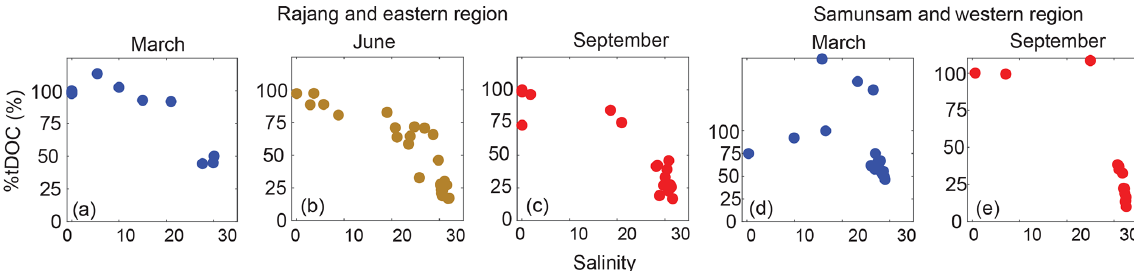
Figure 6. Estimated percentage contribution of terrigenous DOC to the total DOC pool (%tDOC) against salinity for all estuarine samples in the eastern and western